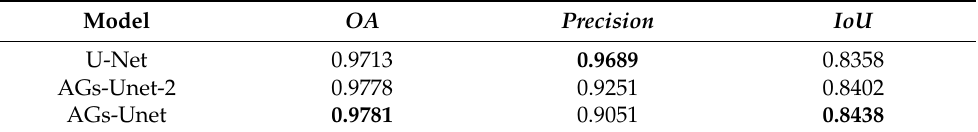
Table 6. Accuracy statistics of ablation experiment in WHU dataset. The best scores are highlighted in bold. Model